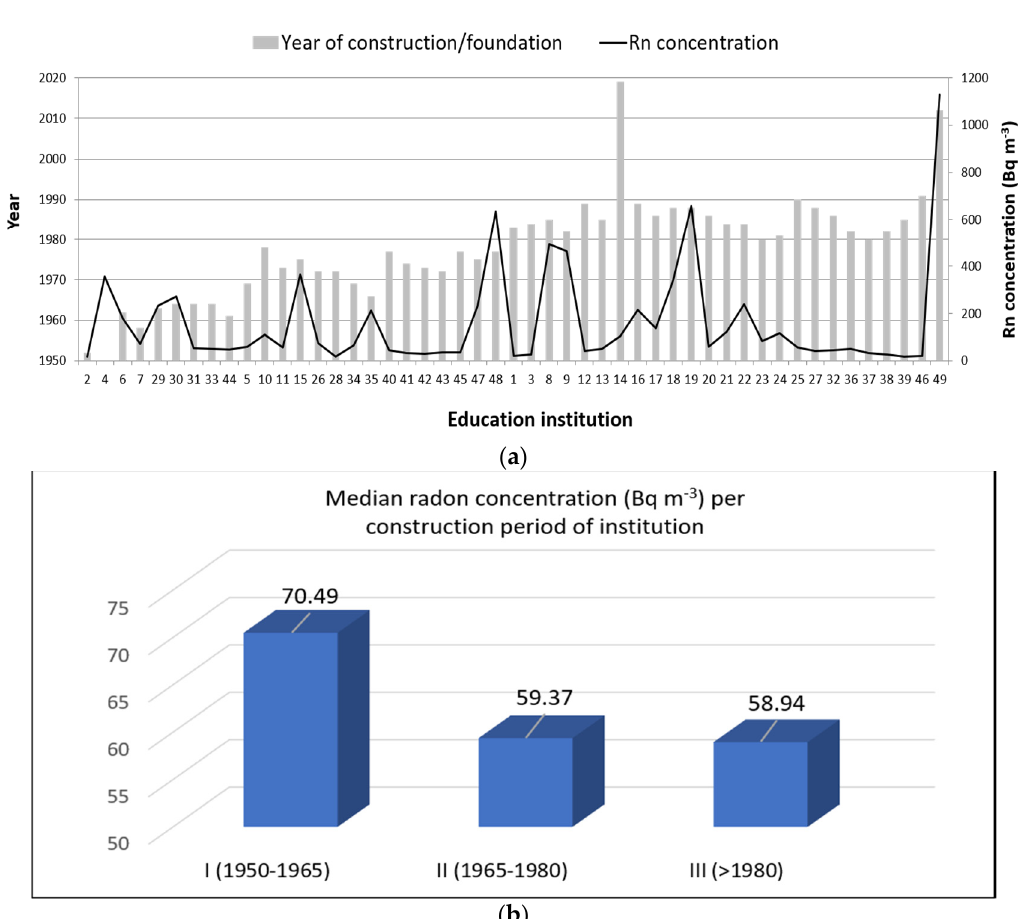
Figure 8. ( a ) Plot of the radon concentration on year of construction ( n = 49 institutions); ( b ) Plot of the variation of the median radon concentration with the age of construction.